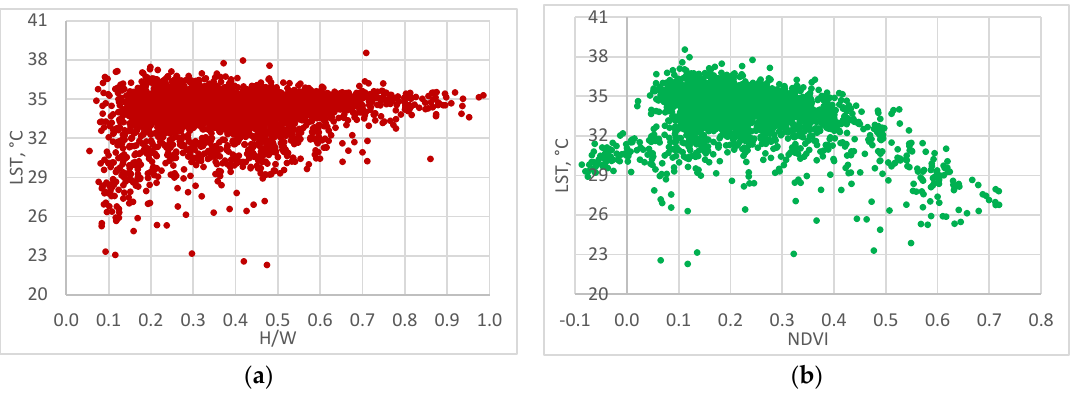
Figure 19. Global data: ( a ) the effect of the H/W ratio and ( b ) the effect of NDVI on LST.